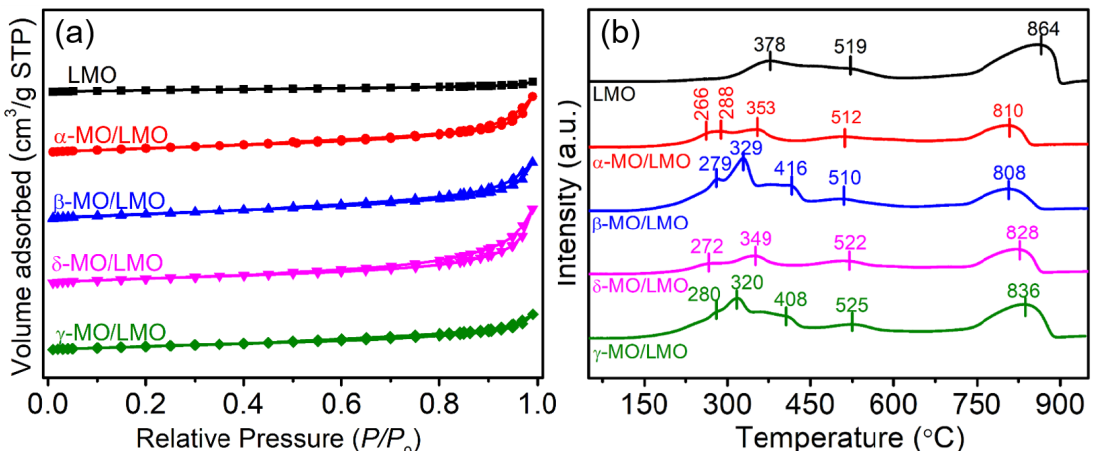
Figure 4. ( a ) N 2 adsorption-desorption isotherms and ( b ) H 2 - TPR profiles of LMO, α - MO/LMO, β - MO/LMO, δ - MO/LMO and γ